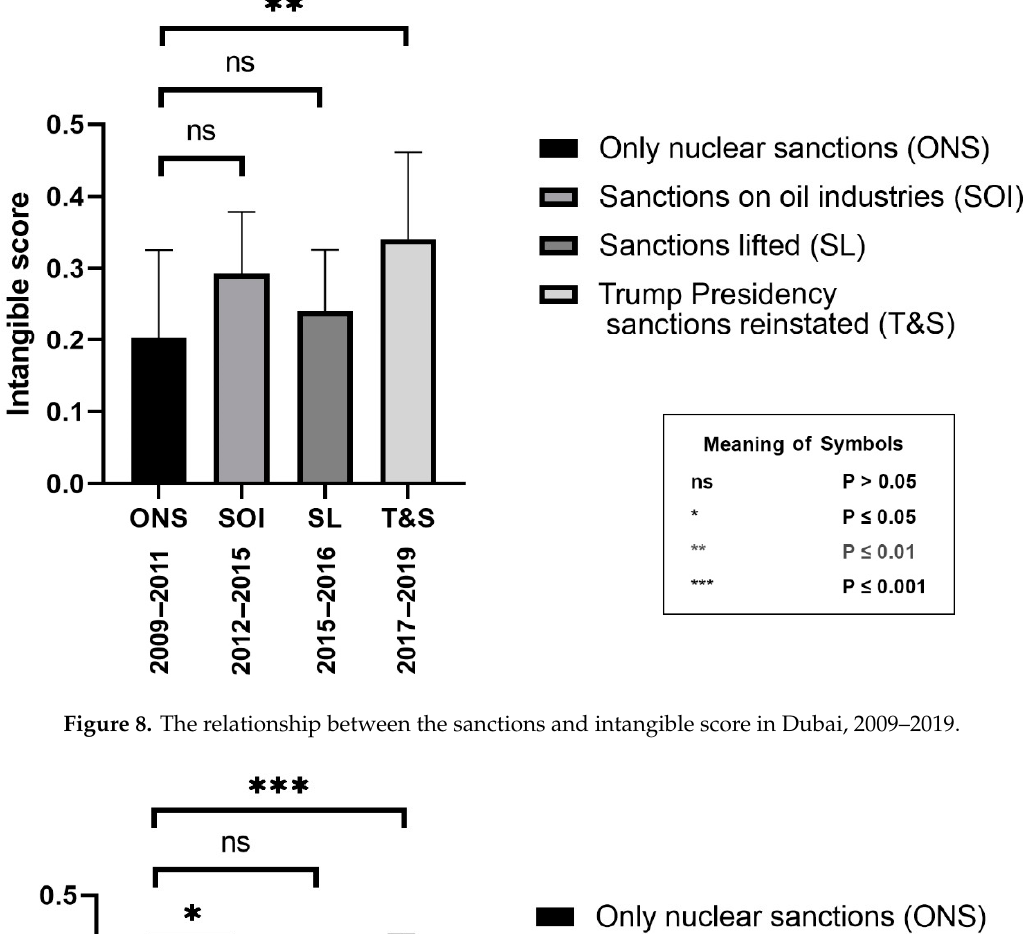
Figure 7. The relationship between the sanctions and intangible score in Tehran, 2009–2019.